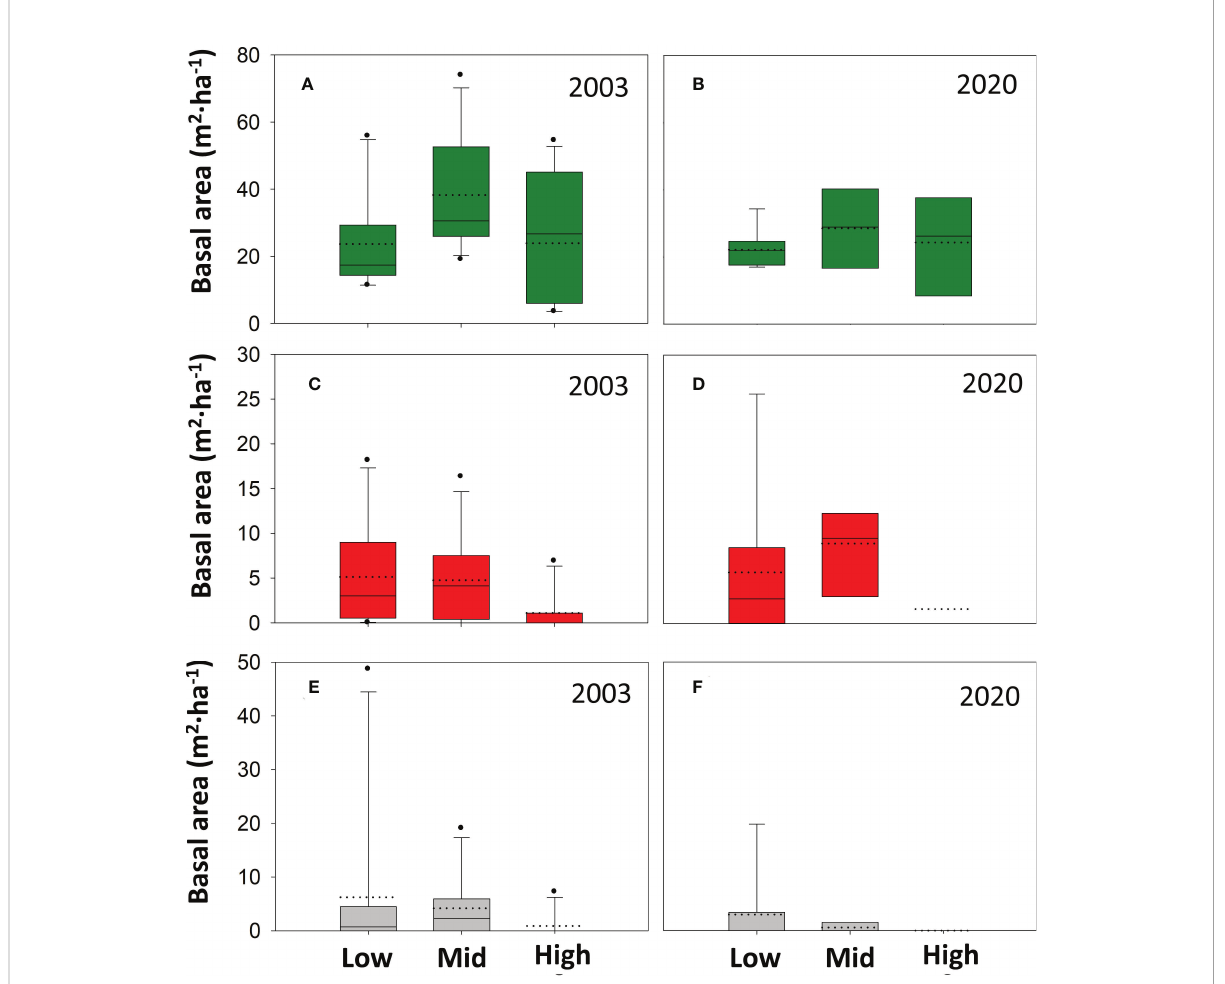
FIGURE 3 Altitudinal distribution in 2003 and 2020 of the basal area of A. pinsapo tree classes. Altitudinal bands: Low (880-1150 m a.s.l.), Mid (1150-1350 m), and High (1350-1550 m). Tree classes: alive trees (in green, A and B ), dead trees (in red, C and D ), and stumps (in grey, E and F ). The ANOVA tests only showed signi fi cant increase in mortality between the 2003 high altitude band and the 2020 mid altitude band (Supplementary Table